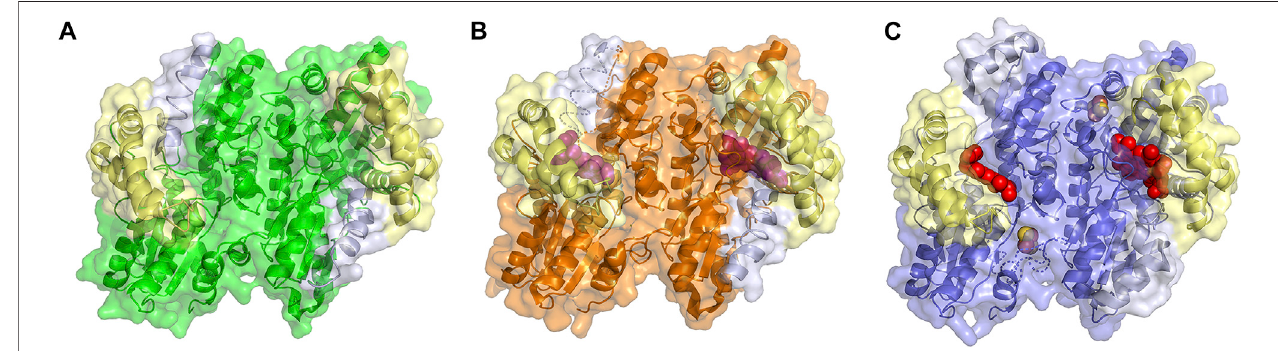
FIGURE 3 | Structure of Ferrchelatase in open, closed and release conformations. Surface and cartoon representations of the (A) open conformation, shown in green(PDBID2HRC), (B) closedconformation,showninorange(PDBID2QD1),and (C) releaseconformation,showninblue(PDBID2QD2).TheFe-Sclusters,shown inorangeandyellow,inallstructuresaswellastheboundporphyrin,showninpurple,intheclosedconformationandheme,showninred,inthereleaseconformationare shown as spheres. The residues of the lip region are shown are colored pale yellow and π helix are light gray. Created using PyMOL Molecular Graphics System (Schrodinger,